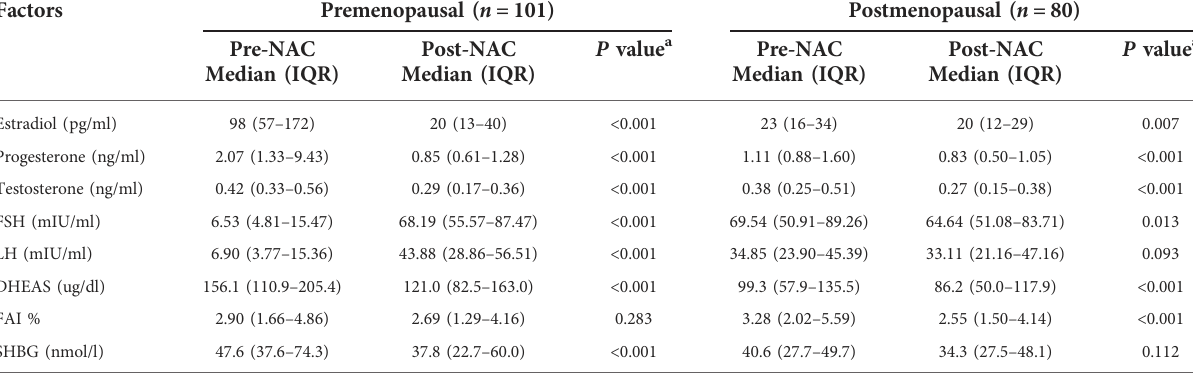
TABLE 2 Serum reproductive hormones changes after NAC treatment in premenopausal and postmenopausal women with breast cancer.